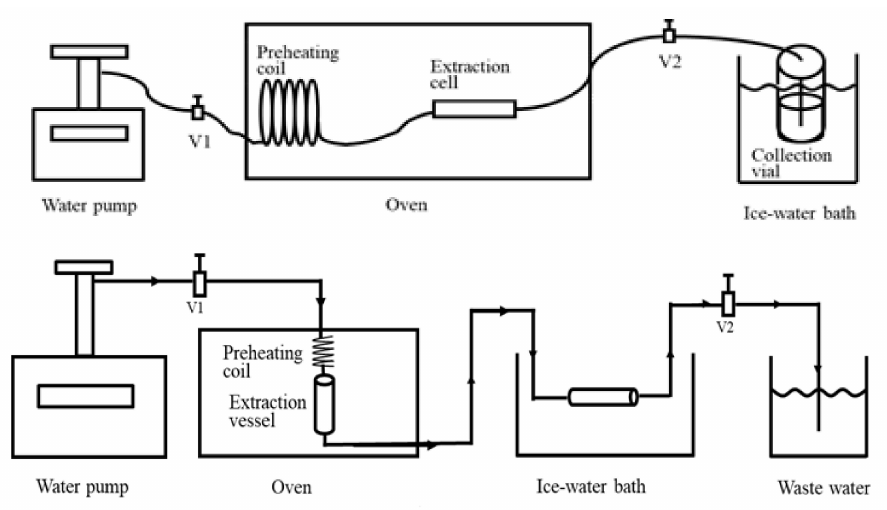
Figure 4. Subcritical water extraction system without solid trapping (top) and with solid trapping